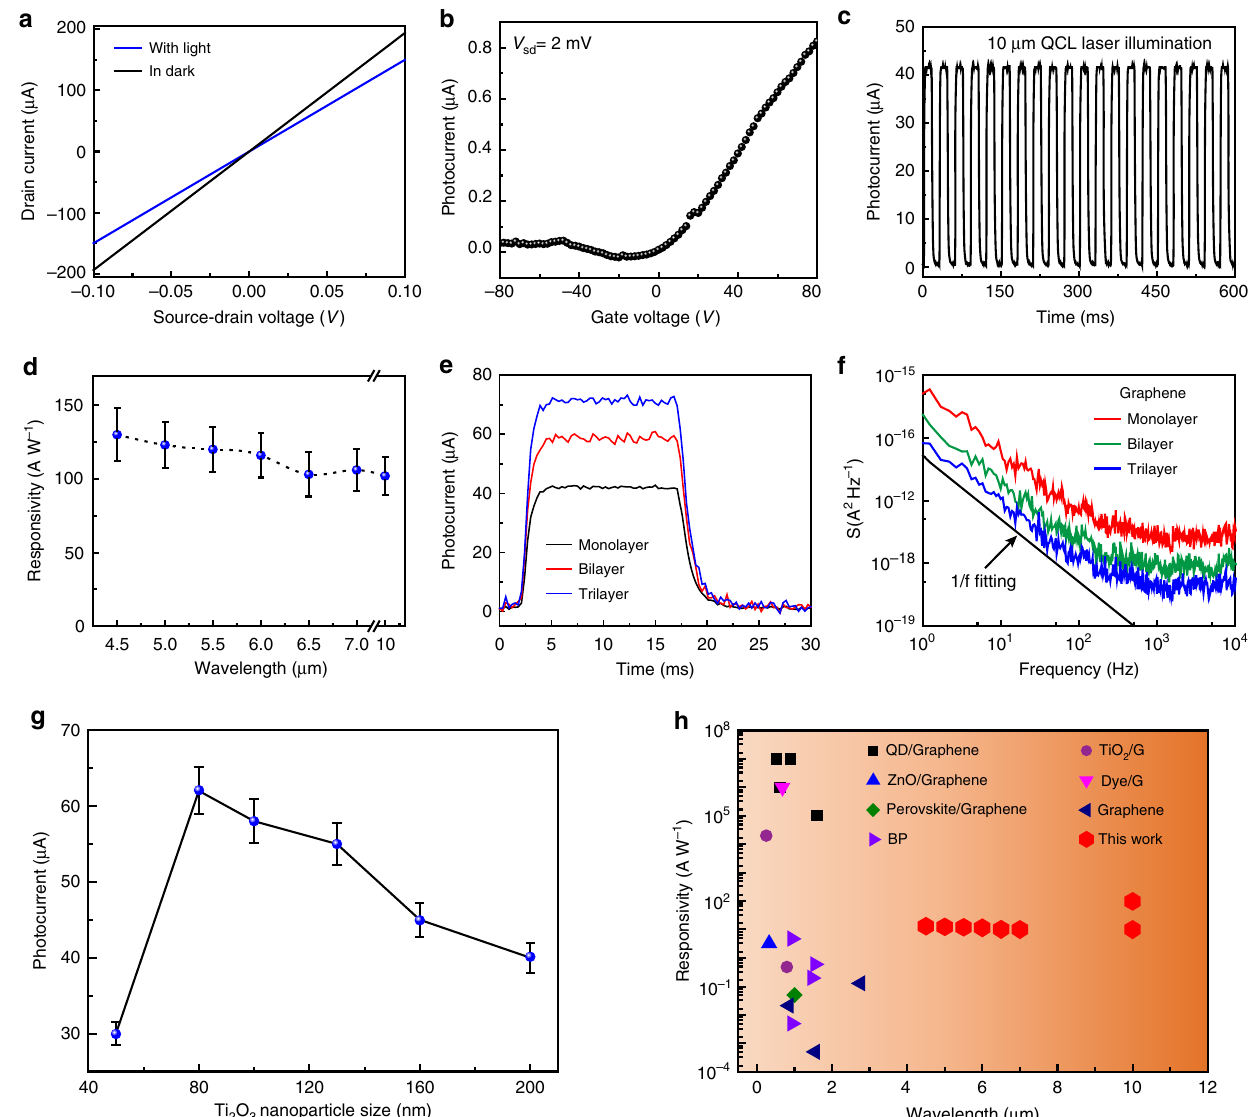
Fig. 4 Performance of the hybrid graphene/Ti 2 O 3 photodetector. a I d − V d curves of the hybrid graphene/Ti 2 O 3 photodetector measured in dark and under quantum cascade laser illumination ( λ : 10 µ m; power: 2 mW/cm 2 ); the gate voltage is 80 V. The channel size is 10.8 µ m × 19.5 µ m. b Corresponding photocurrent of the hybrid graphene/Ti 2 O 3 photodetector plotted as a function of bottom gate voltage. c Temporal response of the device to the illumination of 10 μ m laser. d Responsivity of the hybrid graphene/Ti 2 O 3 photodetector measured at different illumination wavelengths in the mid-infrared regime. The high responsivity measured in the wavelength regime from 4.5 to 10 μ m demonstrated the broadband operation of the hybrid graphene/Ti 2 O 3 photodetector. Error bars represent standard deviation. e Time-dependent photocurrent of the hybrid graphene/Ti 2 O 3 photodetector with monolayer, bilayer and trilayer graphene. In the measurements of ( c ) and ( e ), the laser power was kept at 2 mW/cm 2 , and the source-drain voltage ( V d ) and gate voltage ( V g ) were kept at 2 mV and 80 V, respectively. f Noise spectra of monolayer, bilayer and trilayer graphene hybrid photodetectors as a function of frequency measured at a constant bias voltage of 5 mV. All the current noises show a typical trend of S~1/f α with α = 1. g Photocurrents of hybrid graphene/Ti 2 O 3 photodetectors with different sizes of Ti 2 O 3 nanoparticles measured under 10 µ m laser illumination. The measurement parameters are the same as in Fig. 4c, d. Error bars represent standard deviation. h Comparison of the performance of the hybrid graphene/Ti 2 O 3 photodetector with